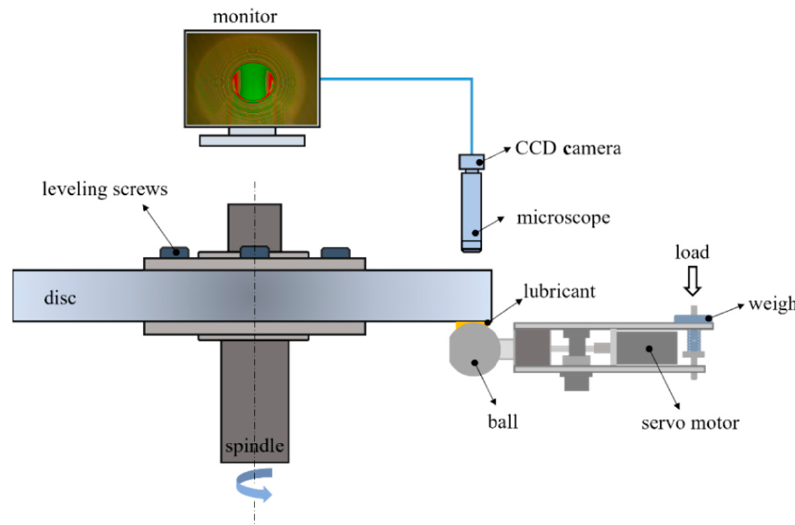
Figure 1. Schematic of the test rig.